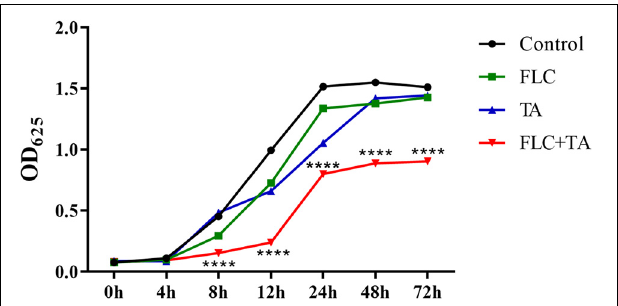
FIGURE 2 | Time-killing curves of C. albicans CA23 treated with TA and TA combined with FLC. The combination group was compared with the FLC group. ****P <